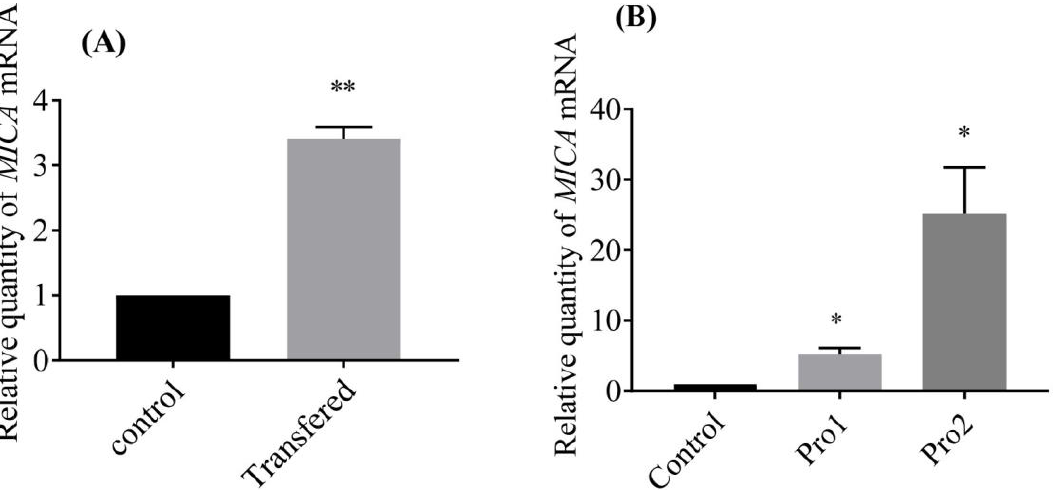
Figure 6. MICA was induced by GmIFN– γ . ( A ) pcDNA3.1-GmIFN– γ was transferred into EPC cells, and the endogenous GmIFN– γ induced the MICA expression; ** indicates p < 0.01. ( B ) EPC cells were incubated with 100 µ g/mL GmIFN– γ for 24 h. Pro1 was from E. coli BL21, while Pro2 was from P. pastoris GS115; * indicates p < 0.05.